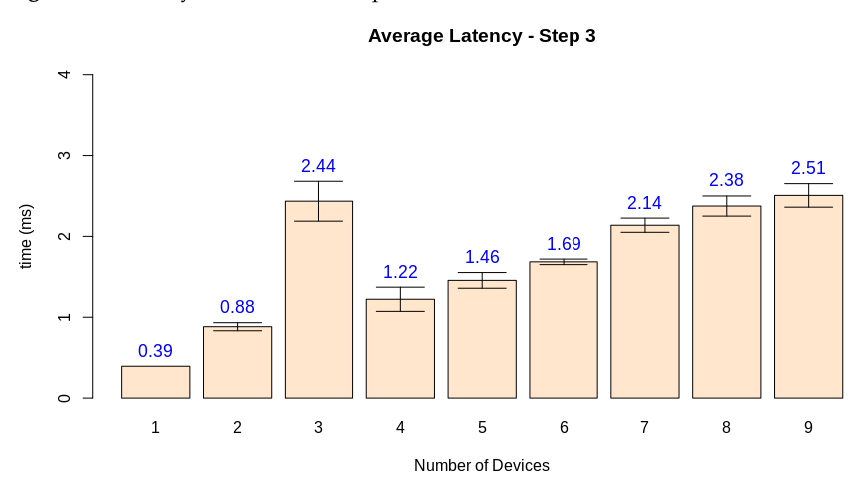
Figure 27. Latency test results for step 2.